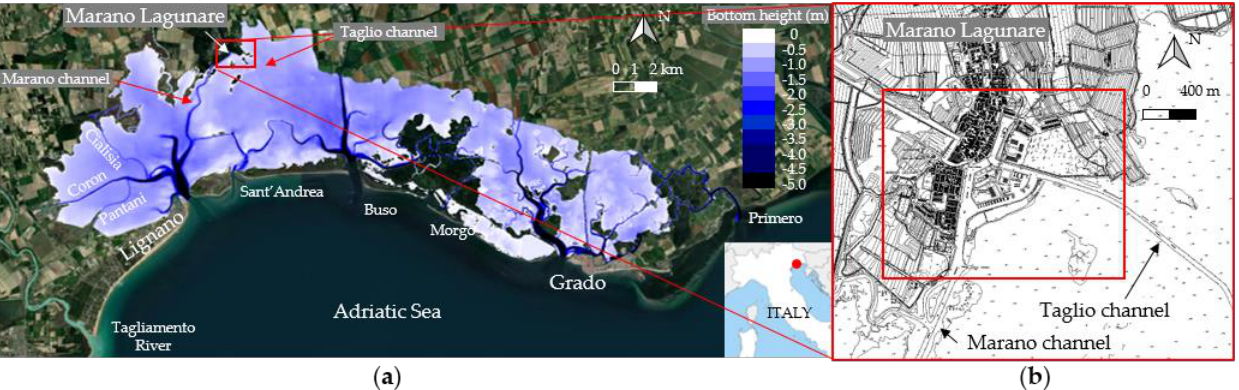
Figure 1. ( a ) The Marano and Grado lagoon in the northern Adriatic Sea, Italy: bathymetry data arising from the survey by Triches et al. [43] superimposed onto World Imagery satellite imagery (QGIS); ( b ) a detail of the regional cartography from 2003 of the Marano Lagunare area (http://www.regione.fvg.it/rafvg/cms/RAFVG/ accessed on 1 September 2021); the red rectangle delimits the area depicted in Figure 2.